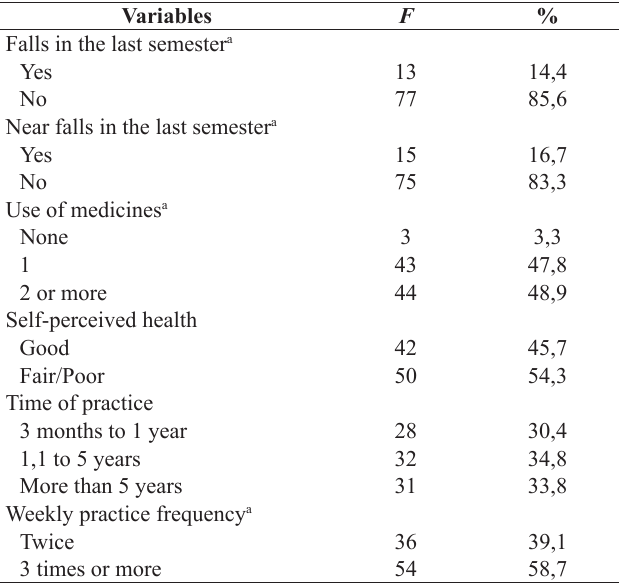
Table 2. Distribution of the health profile frequency of the elderly who practice physical exercises. Maringá, Paraná, Brazil,